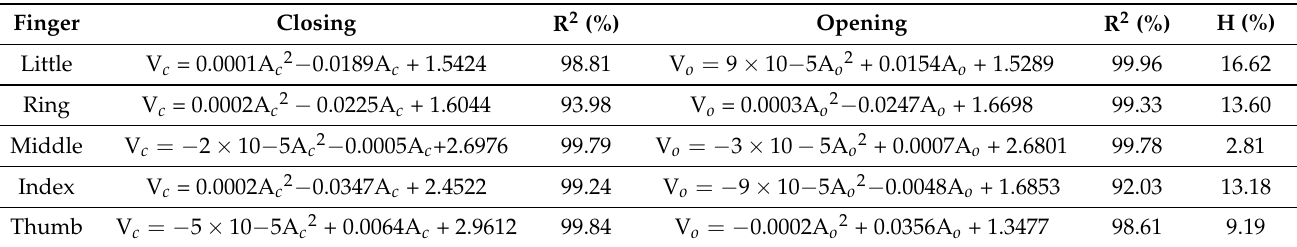
Table 2. Angle voltage equations per